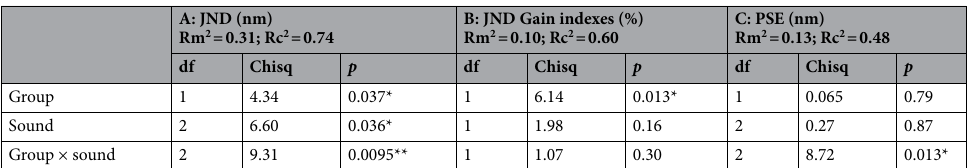
A: JND (nm) Rm 2 = 0.31; Rc 2 =